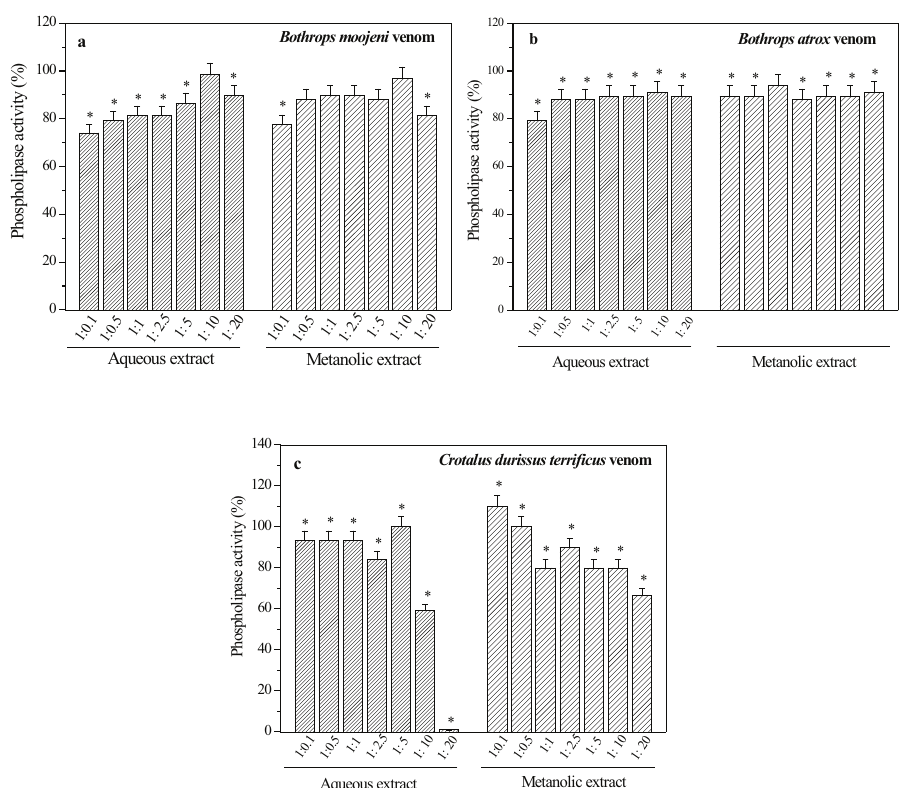
Figure 3 - Phospholipase activity (%) induced by the venoms of snakes from the species: Bothrops moojeni ( a ), Bothrops atrox ( b ) and Crotalus durissus terrificus ( c ), previously incubated with aqueous and methanolic extracts of jabuticaba skin. Controles (+) containing only venom (30 µg) was considered as having 100% of activity. The results correspond to the average of triplicates of the data obtained for each proportion (venom: extract, w:w) and the standard deviations. *the averages differ statistically from the respective positive control by the Dunnett test